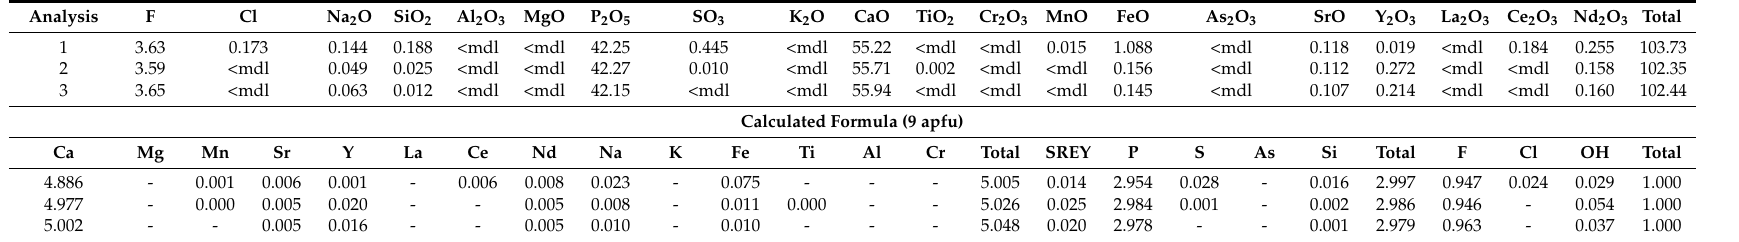
Table 8. EPMA data for the high-grade bornite-ore hosted apatite, <mdl—below minimum detection